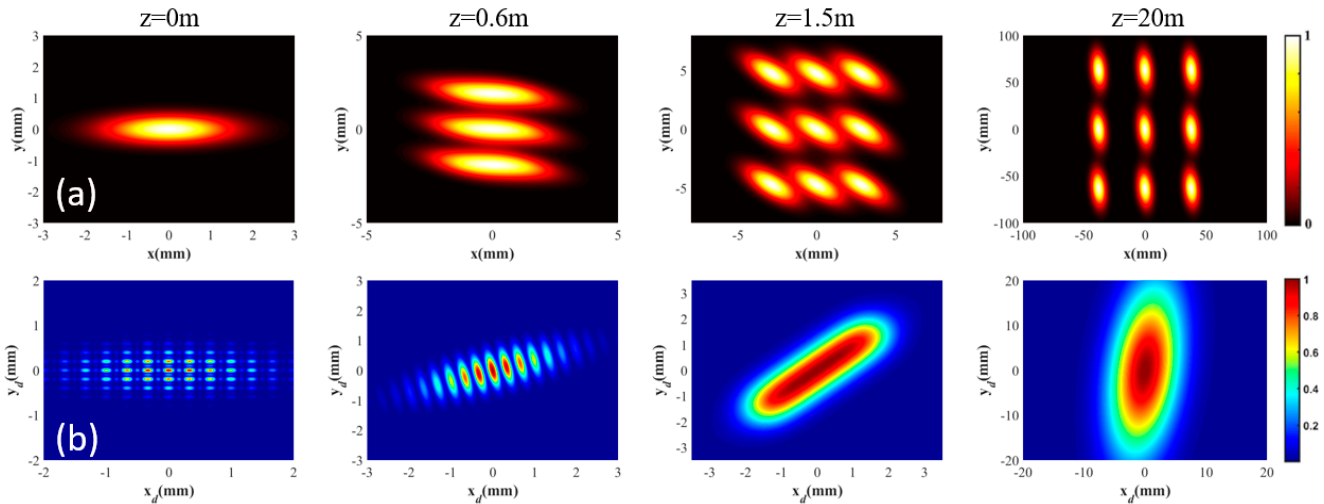
Figure 1. The distribution of ( a ) spectral density and ( b ) degree of coherence (DOC) associated with a typical twisted Gaussian Schell-model (TGSMA) beam propagating in free-space.